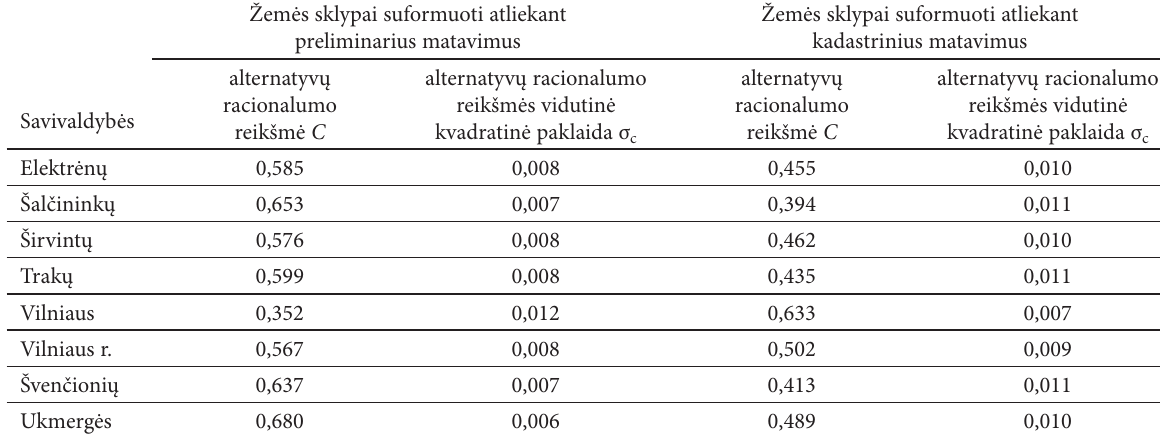
Table 4. The rationality precision evaluation results of the